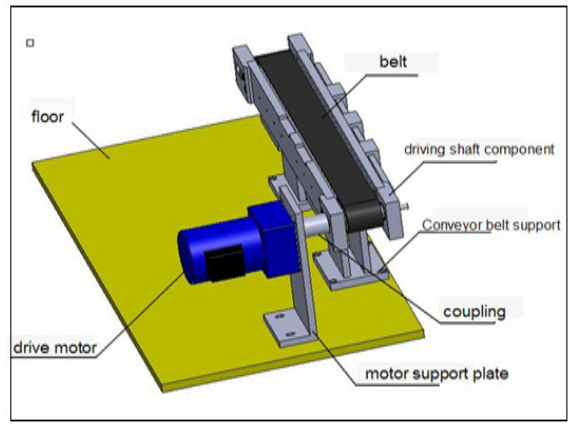
Fig. 6. The sorting